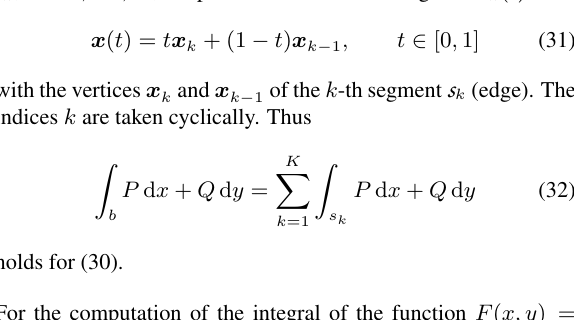
Table 1. Decompositions for the computations of moments fol- lowing (Steger, 1996b). For polygons, i.e., closed sequences of K straight line segments s k , k = 1 , . . . , K , the parametrization of the segment s k ( t )